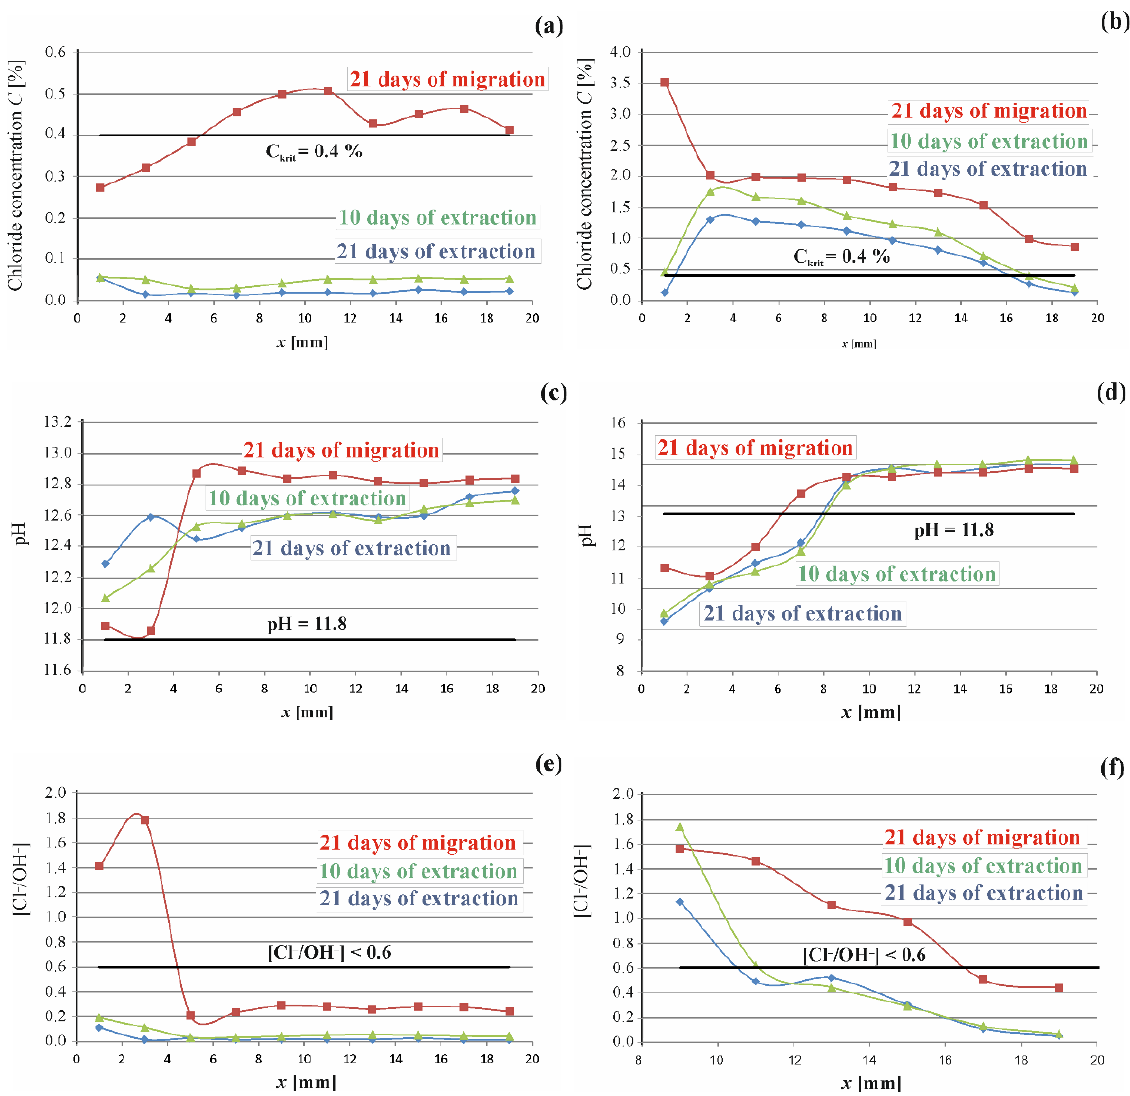
Figure 8. Test results obtained for reinforcement concrete C1 and C2 after 21 days of migration chloride ions, after 10 days and 21 days of extraction processes: ( a , b ) profiles of chloride concentrations; ( c , d ) distribution of pH values; and ( e , f ) distributions in the direction x of concrete cover thickness, values of concentration ratios of chloride and hydroxide ions—the Hausman